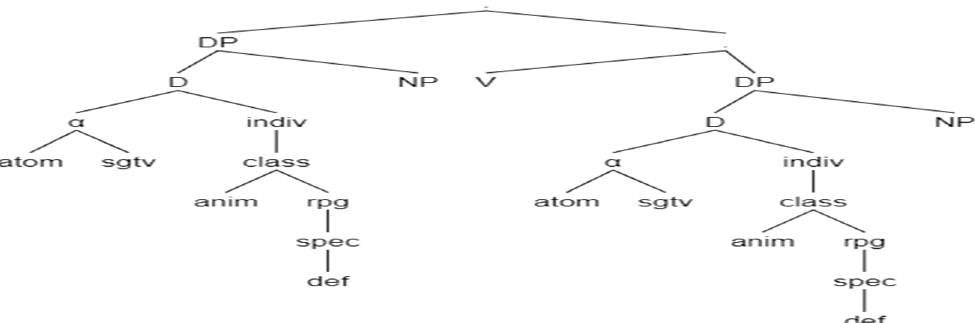
Figure 26. Before insertion of v*, inheritance, Agree, and labeling.